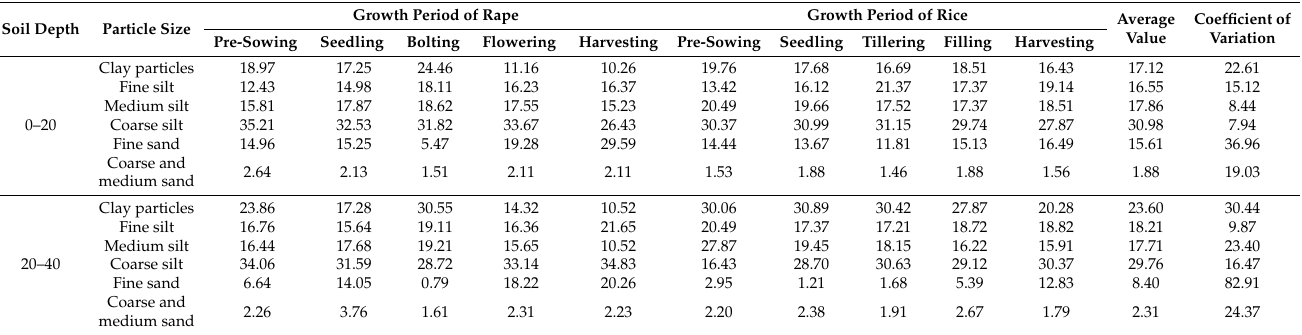
Table 3. Changes of soil machinery during rice–rape rotation (unit:%).